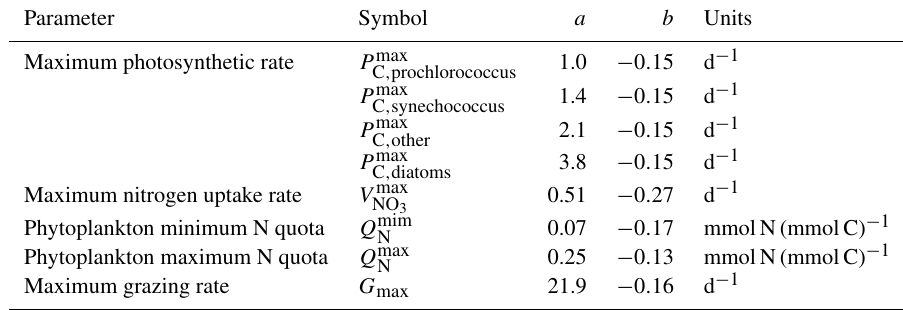
Table 2. Size-dependent parameters (adapted from Ward et al., 2012; see references within). Coefficients a and b are used in the power-law function that assigns parameters as a function of plankton cell volume p = aV b